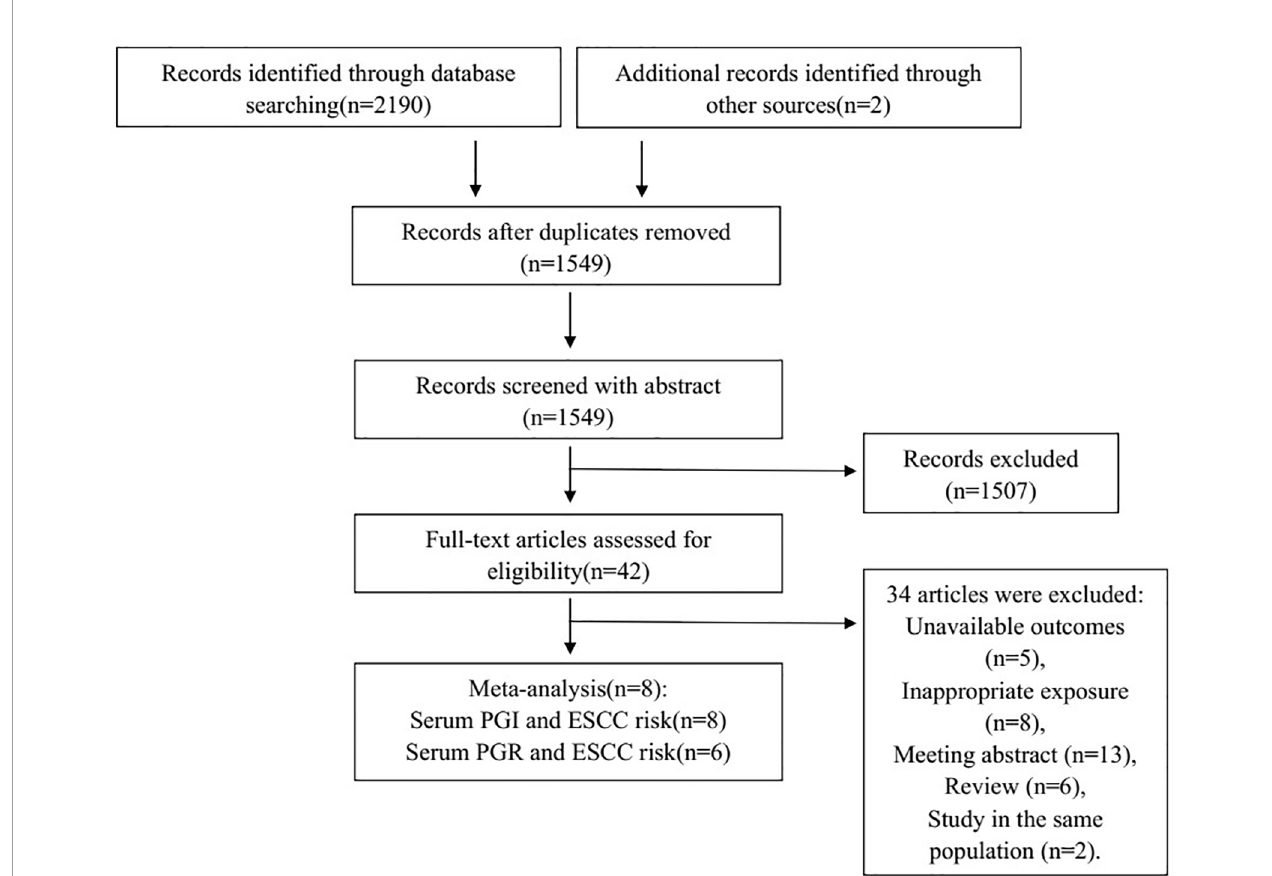
FIGURE 1 | Flowchart of selection of eligible studies. PGI, pepsinogen I; PGR, pepsinogen I: pepsinogen II ratio; ESCC, esophageal squamous cell